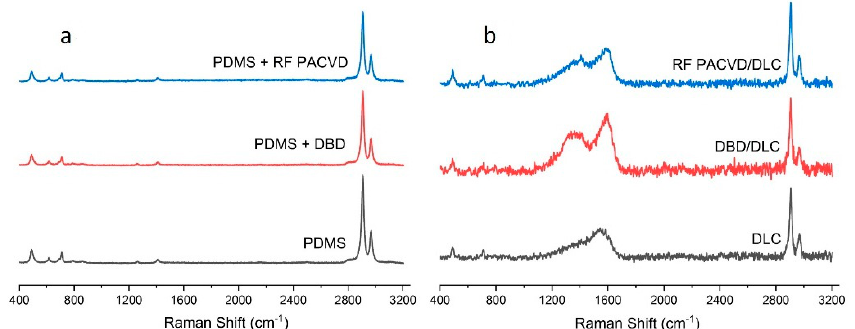
Figure 4. Raman spectra characteristic of ( a ) unmodified polymer substrate and also substrate after 60 s pre-treatment using DBD or RF PACVD plasma, and ( b ) after the production of DLC coatings.